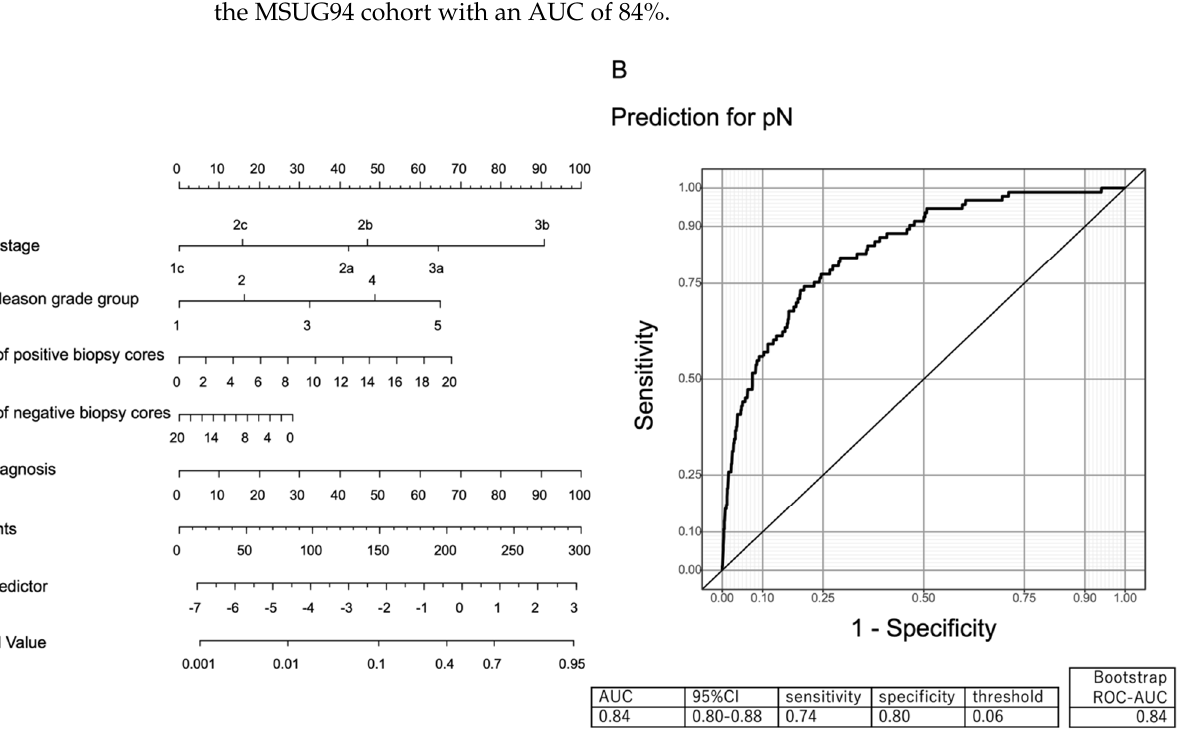
Table 3. Systematic analyses of the nomogram-derived probability cutoffs for prostate cancer with lymph node involvement.